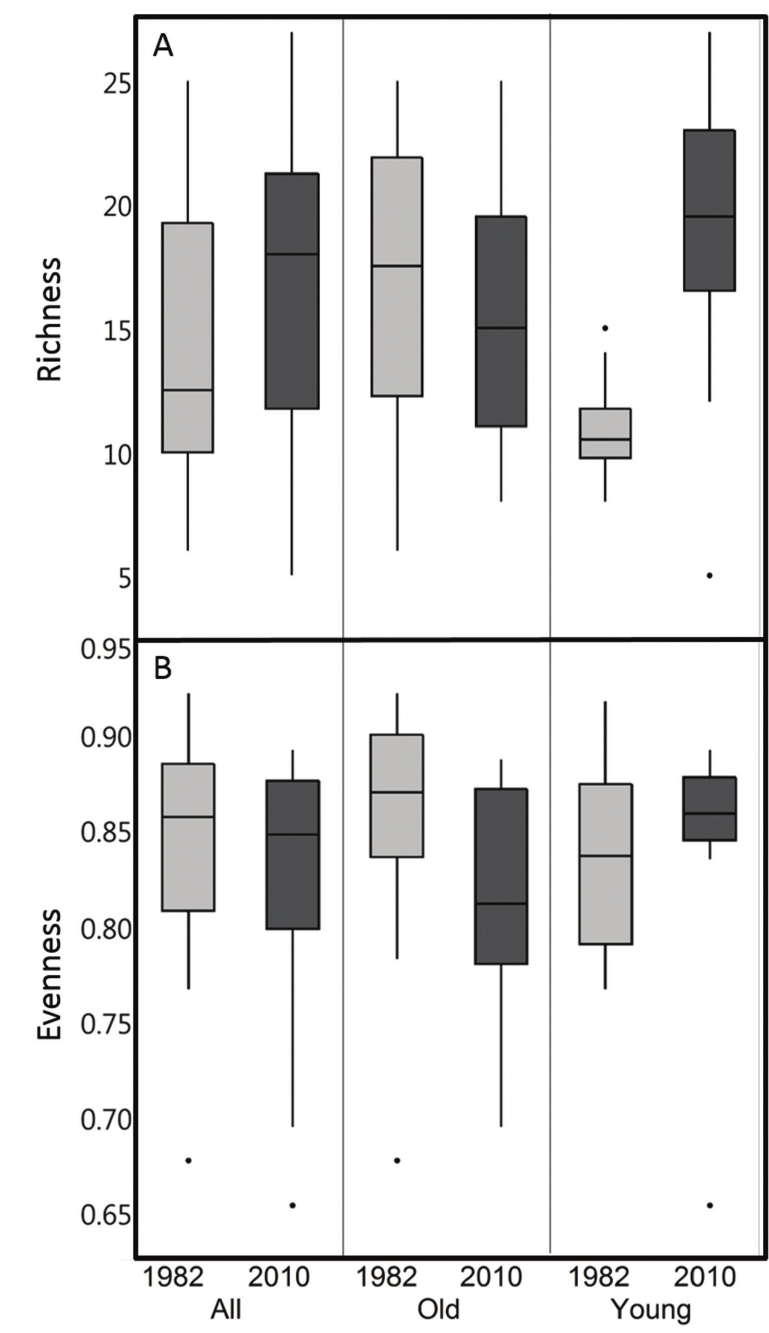
Figure 1. Richness and evenness of pond macrophytes in 1982 (light grey) and 2010/2011 (dark grey). Medians, first and third quartiles, interquartile ranges and outliers are shown. Richness and eveness differ- ences were evaluated via ANOVAs (see Table